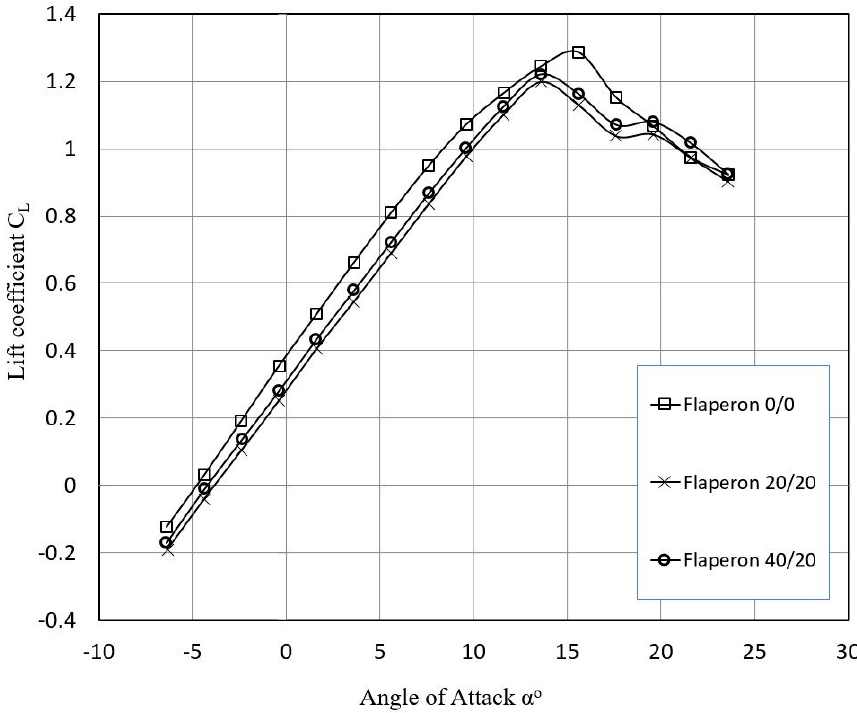
Figure 17 . Lift curve for cruise, take-off, and landing configuration. Data taken from [19]. Figure 17. Lift curve for cruise, take-off, and landing configuration. Data taken from